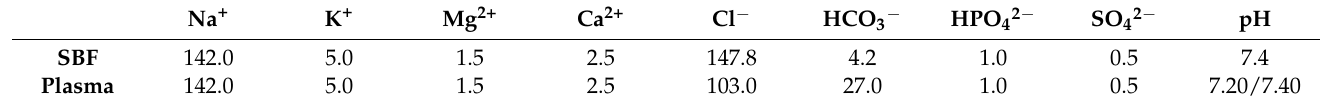
Table 8. Comparison between the composition (mM) of human plasma and simulated body fluid